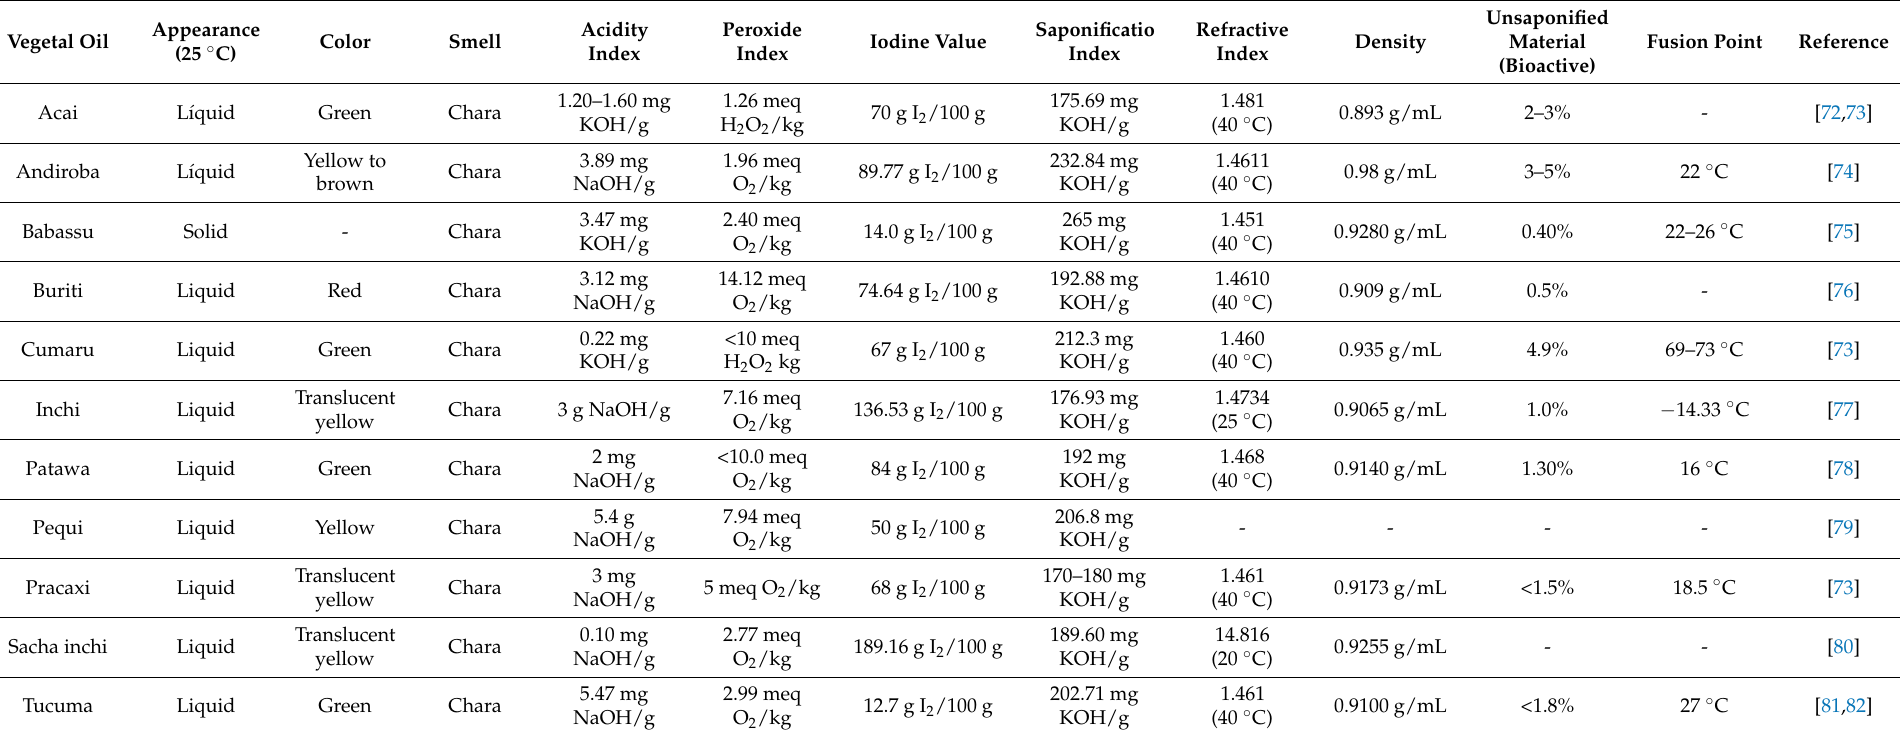
Table 1. Physicochemical properties of different Amazonian vegetable oil by alphabetical order; (-): not